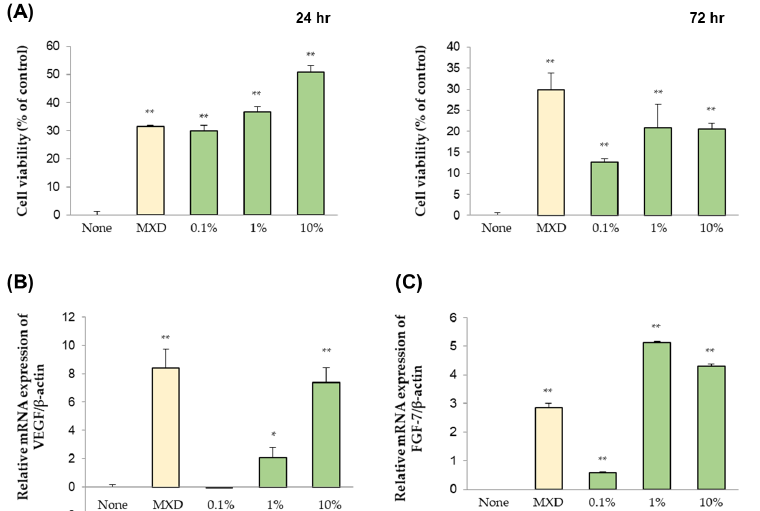
Figure 2. Cell proliferation efficacy of Cicaria culture supernatant by time (24 and 72 h) and concen- tration ( A ). Expression of the vasodilator gene ( B ) and epidermal cell growth factor gene ( C ) by the concentration of Cicaria culture supernatant . * p < 0.05, ** p < 0.01.